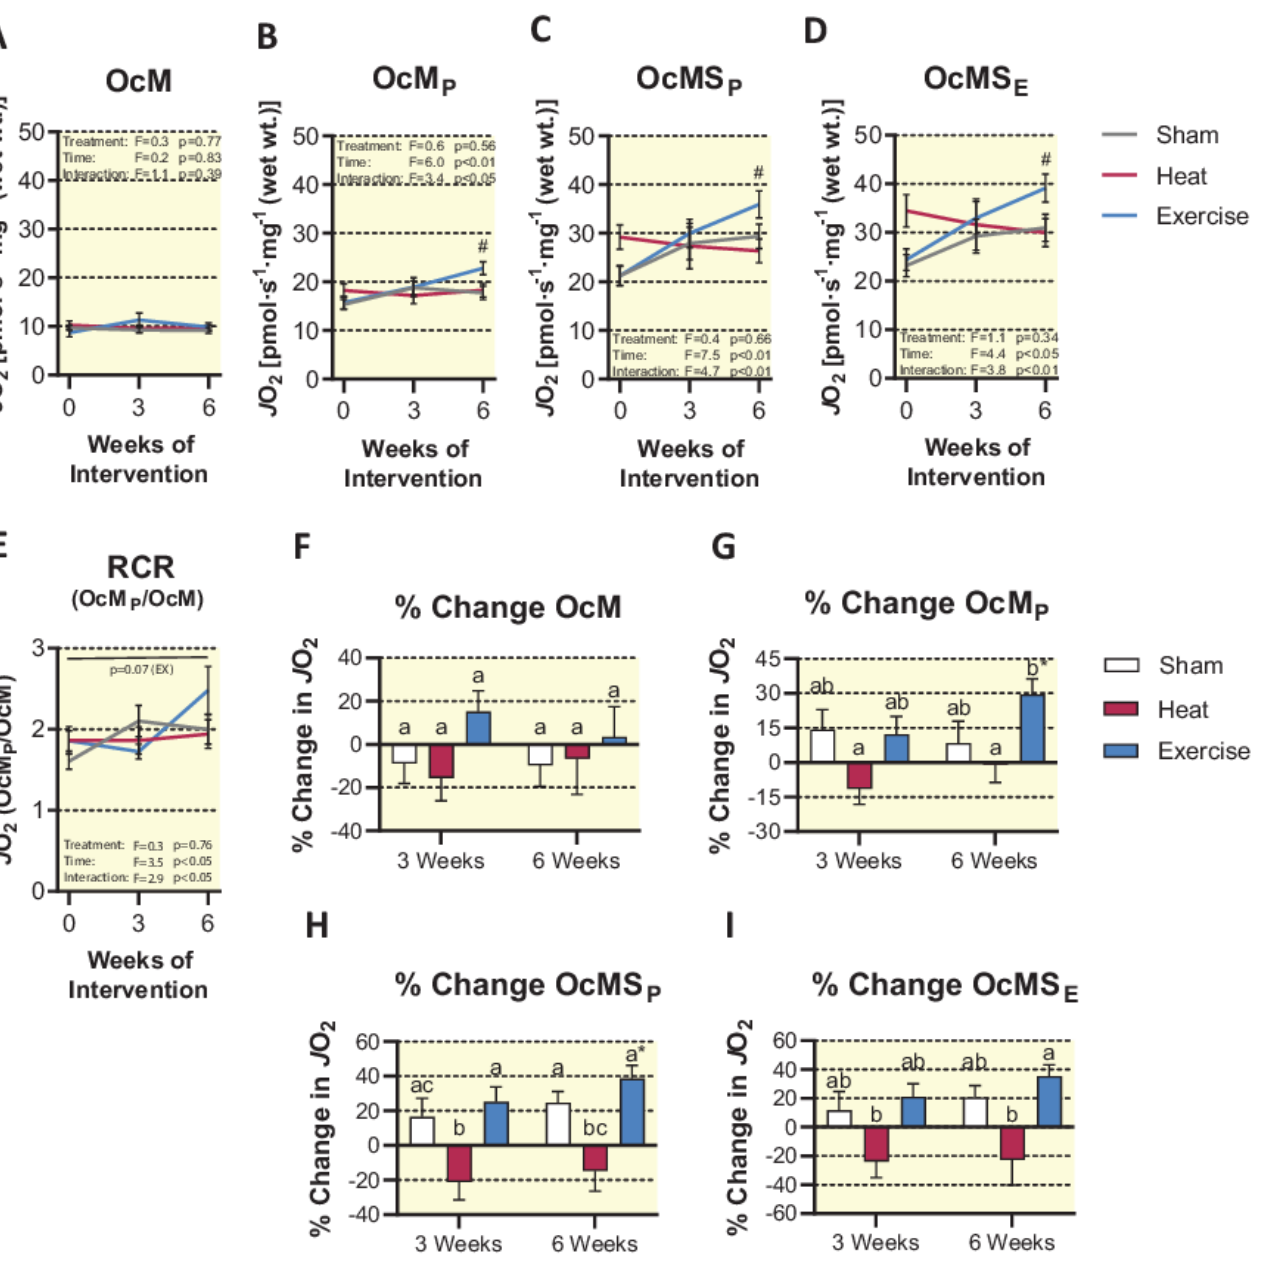
Figure 7. Mitochondrial fatty acid oxidation expressed as absolute respiration over the course of the intervention ( A–D ) and respiratory control ratio ( E ). Respiration expressed as a percent change from baseline in each group ( F–I ). Statistical difference in the EX group compared to baseline is indicated by # ( p < 0.05). In panels E-G, shared letters are no different from each other, and an asterisk (*) indicates a significant difference from baseline ( p < 0.05). Results are represented as mean ± SEM ( n = 9–10).